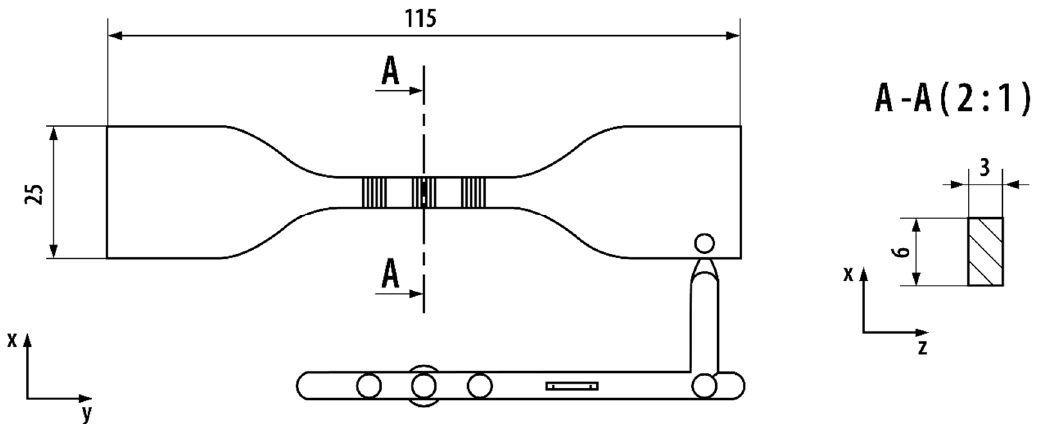
Figure 2. Scheme of the mold cavity and runner (length in millimeters). Table 1. Injection molding parameters.